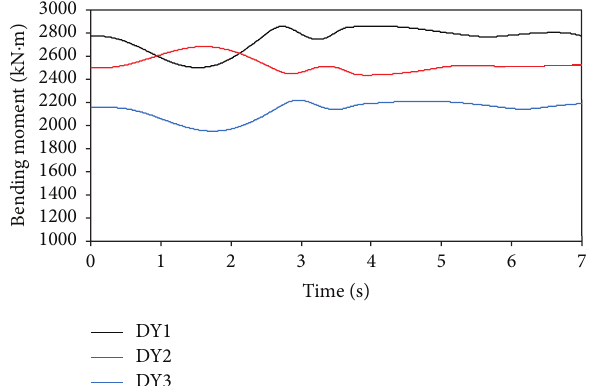
Figure 12: Anchor cable axial force time history. Monitoring site DM1 (black), monitoring site DM2 (red), monitoring site DM3 (purple), and monitoring site DM4